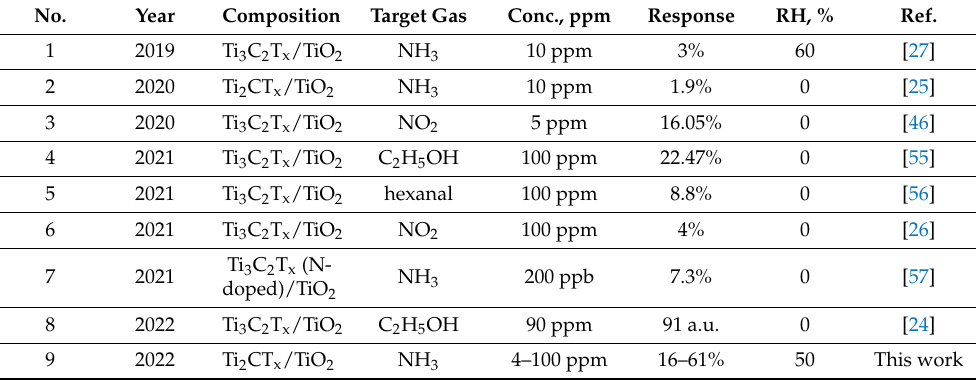
Table 1. Comparison of gas-sensitive characteristics of chemoresistive gas sensors based